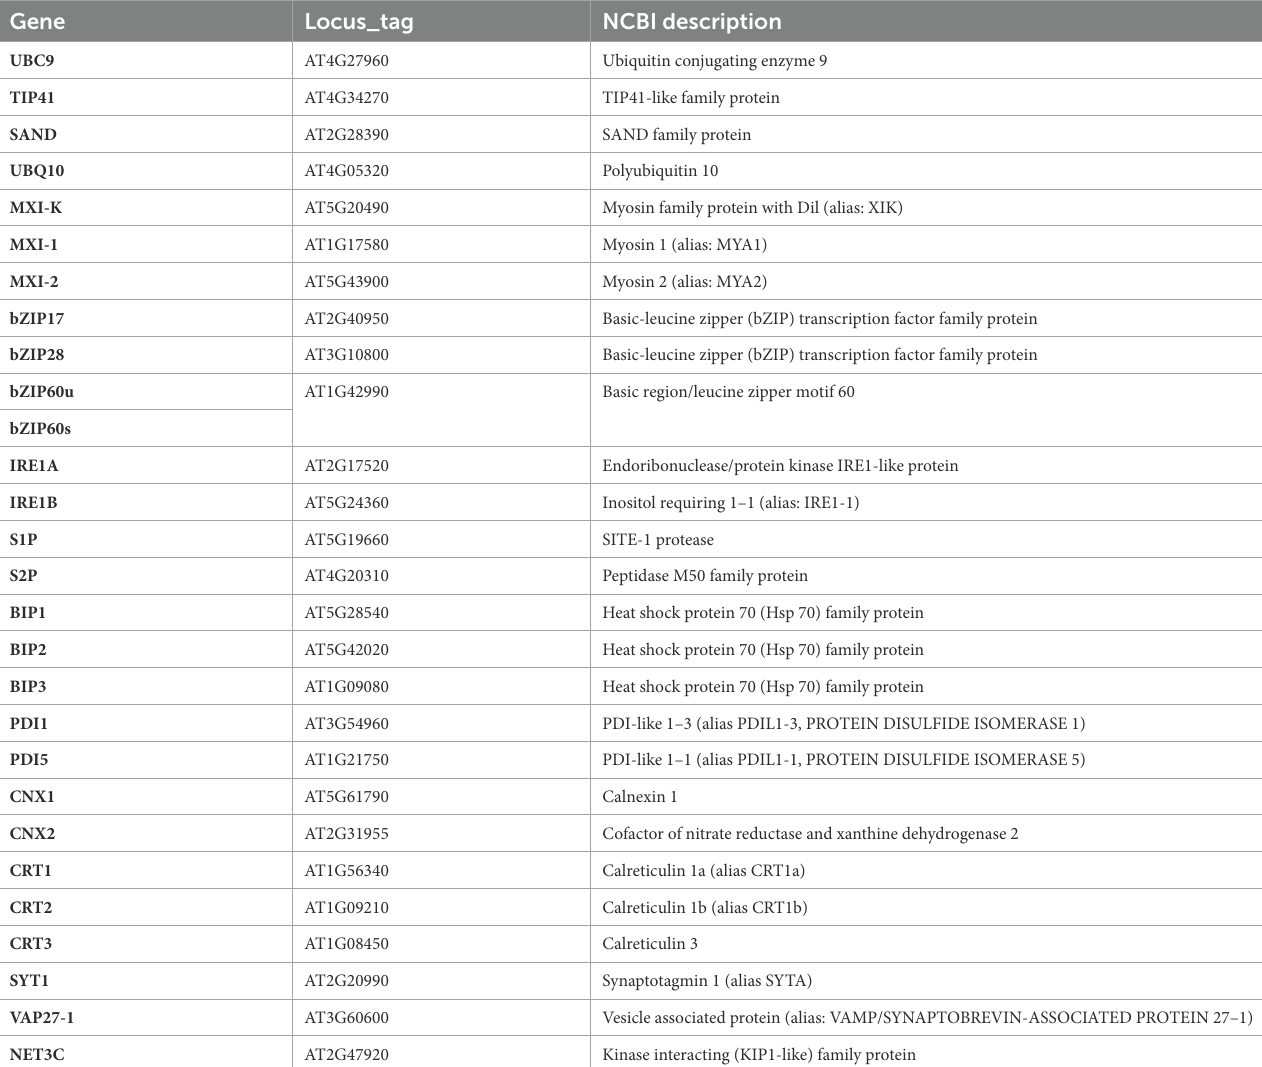
TABLE 1 List of Arabidopsis genes examined by real-time RT-PCR in this study.